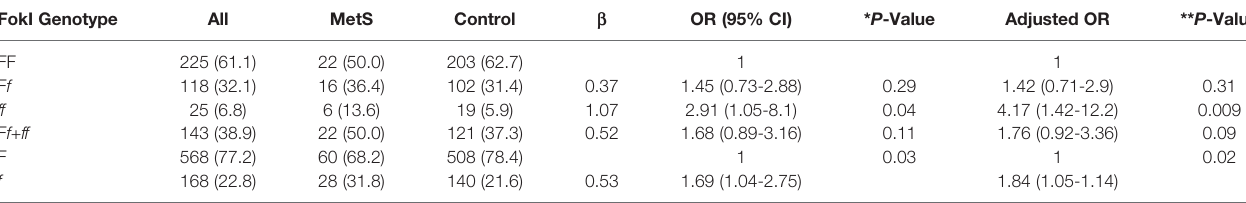
TABLE 2 | Genotype distribution of VDR FokI polymorphisms in MetS and control groups. FokI